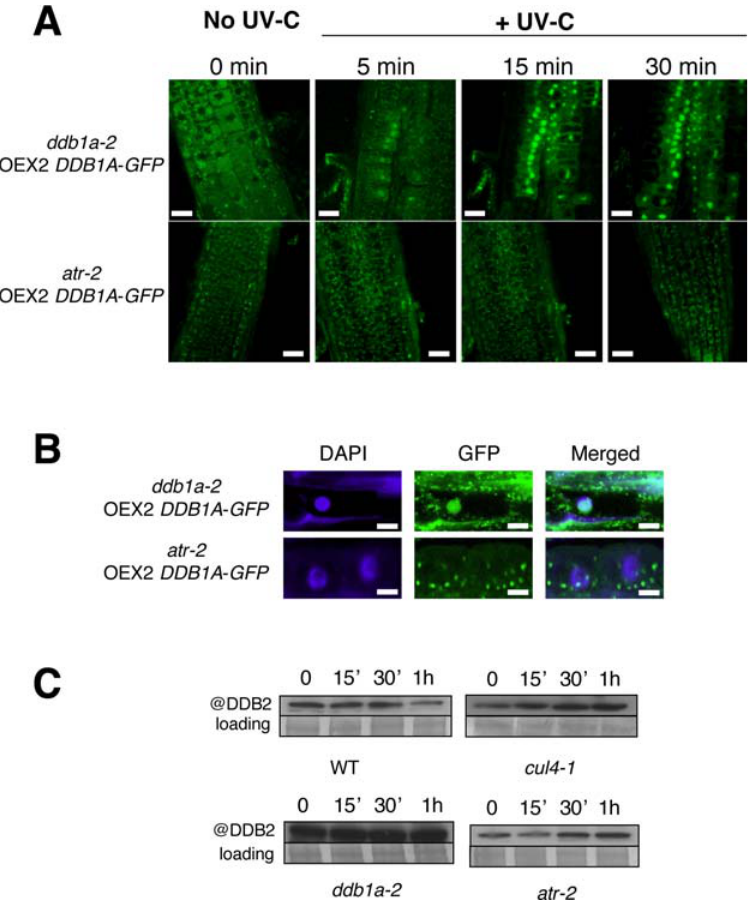
Figure 6. ATR-dependent DDB1A-GFP nuclear shuttling and DDB2 stability. (A) DDB1A-GFP dynamics upon UV-C exposure (600 J/m 2 ) in WT (upper panel) and in atr-2 mutant plant (lower panel). Bar=75 m m. Pictures are representative of 3 different experiments using 2 independent transgenic lines. (B) Higher magnification of DDB1A-GFP localisation 15 min upon UV-C exposure in either ddb1a-2 or atr-2 mutant backgrounds. Chromatin is stained by DAPI (blue). (C) Immunoblot revealing DDB2 content upon UV-C exposure (900 J/m 2 ) in WT, cul4-1 , ddb1a-2 and atr-2 Arabidopsis plants. Coomassie blue staining was used as loading control.